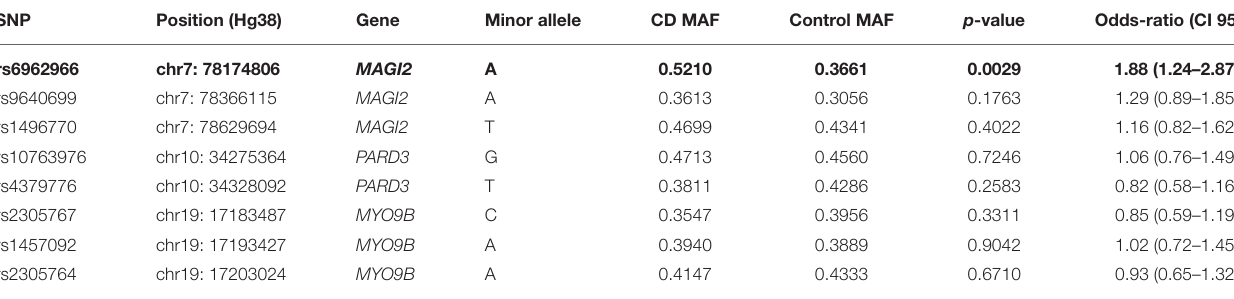
TABLE 1 | Association analysis of single nucleotide polymorphisms in TJ-related candidate genes in CD. SNP Position